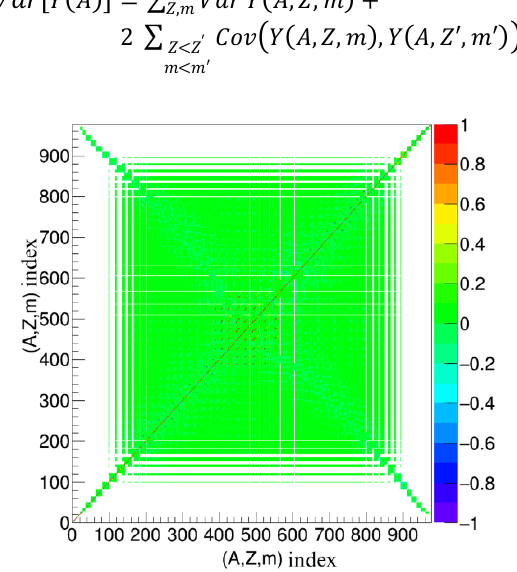
Fig. 12. Independent fission yield correlation matrix of 235 U(n th ,f)